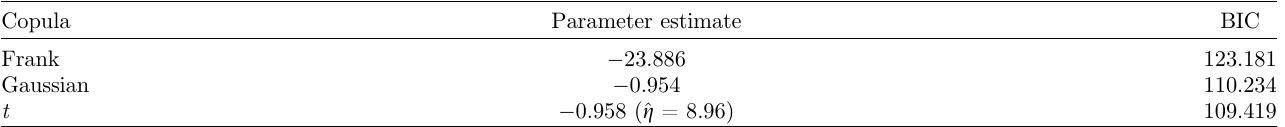
Table 1. Parameter estimate by Maximum Pseudo Likelihood Method and BIC value for the copula between the pseudo-observations ranks ( X 1 ) and ranks ( X 2 ).